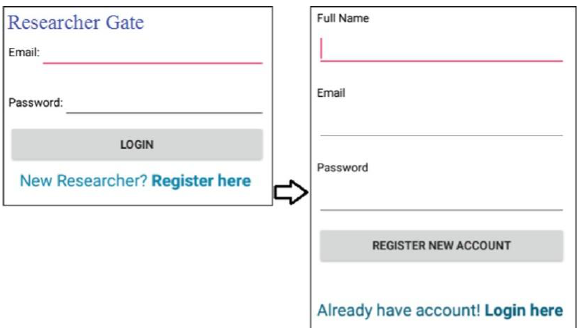
Figure 2. Login and register activity interface